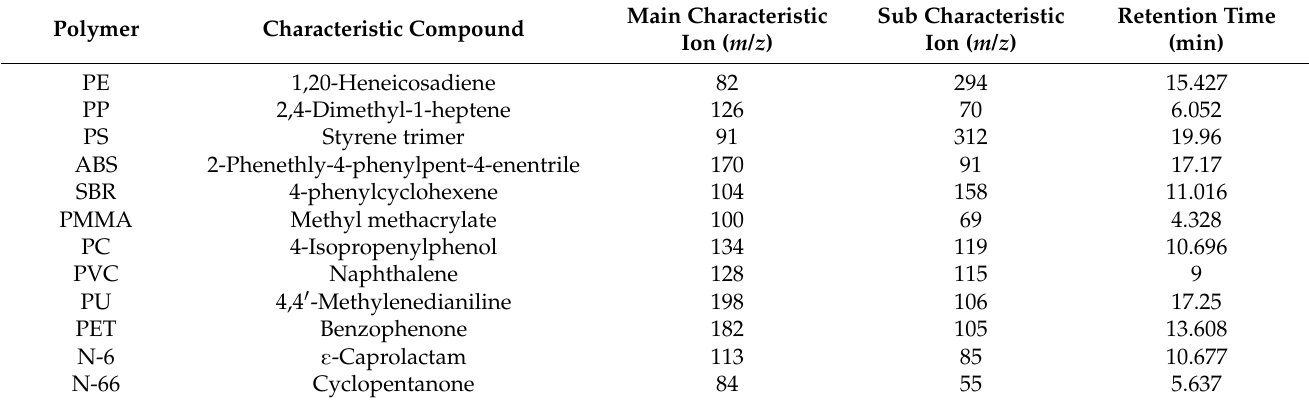
Table 2. Characteristic compounds for 12 polymers, their characteristics ions, and retention